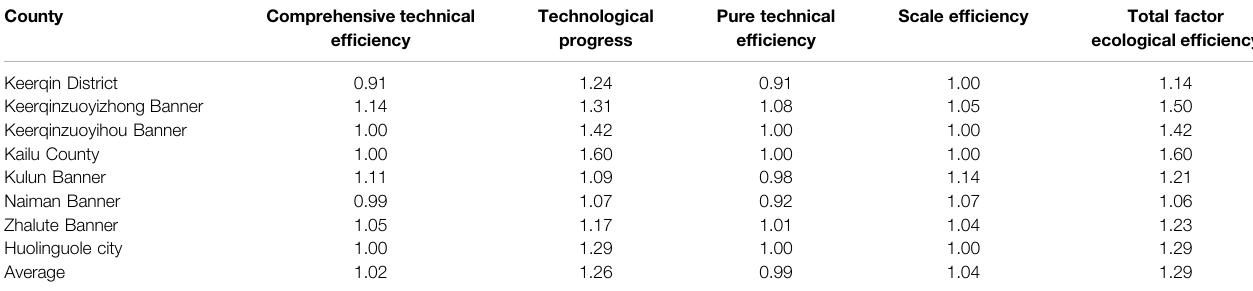
TABLE 3 | Malmquist index and its decomposition of counties in Tongliao from 2000 to 2019.